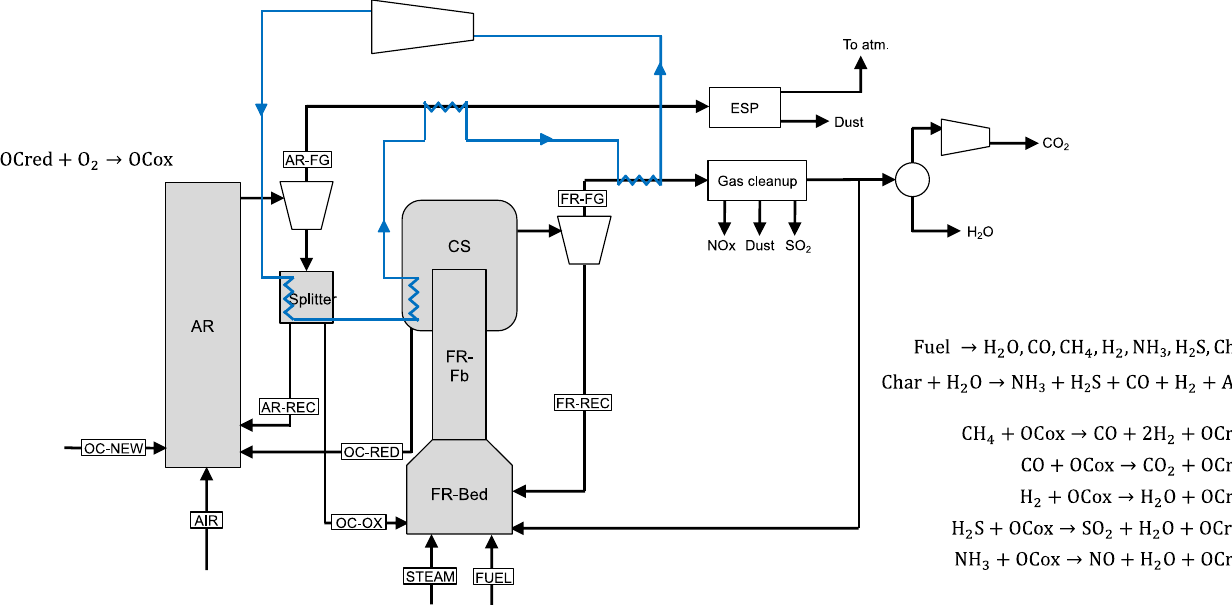
Figure 1. Schematic representation of the solid fuel CLC process considered in this study and the typical reactions taking place in the air and fuel reactors.